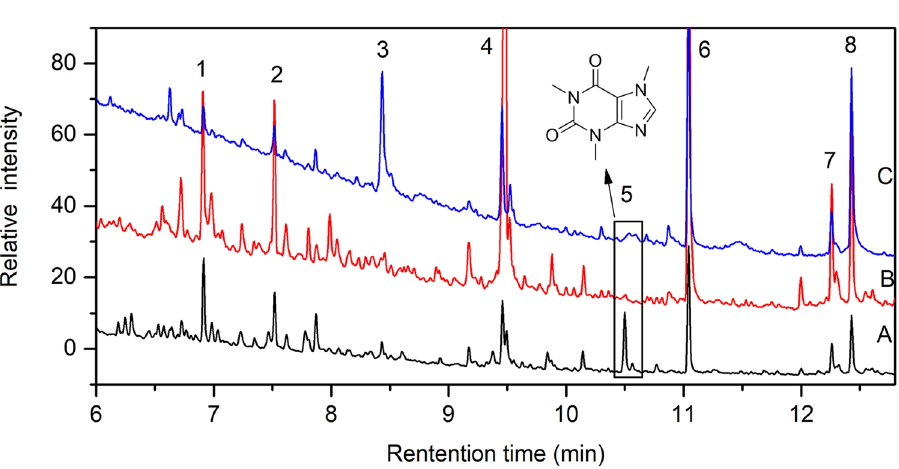
Figure 5. TIC chromatogram obtained by THM-Py-GC/MS of A—modern tea; B—modern tea residue; C—sample CST; The peak numbers are corresponding to: (1): 1,3,5-trimethoxy-benzene; (2): 2,4,6-trimethoxytoluene; (3): 3,4-dimethoxy-benzoic acid, methyl ester; (4): 3,4,5-trimethoxy-benzoic acid, methyl ester; (5): caffeine; (6): hexadecanoic acid, methyl ester; (7): 9-octadecenoic acid, methyl ester; (8): methyl